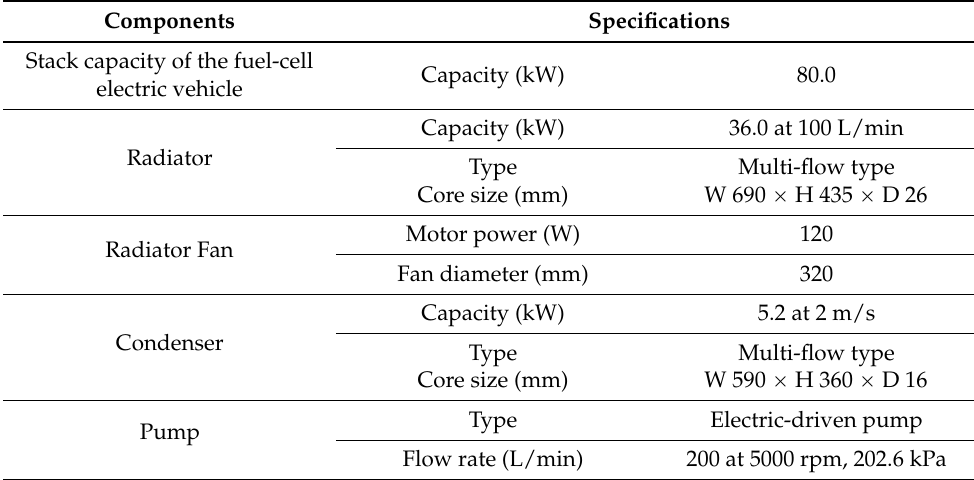
Table 1. Component specifications of the stack cooling system.